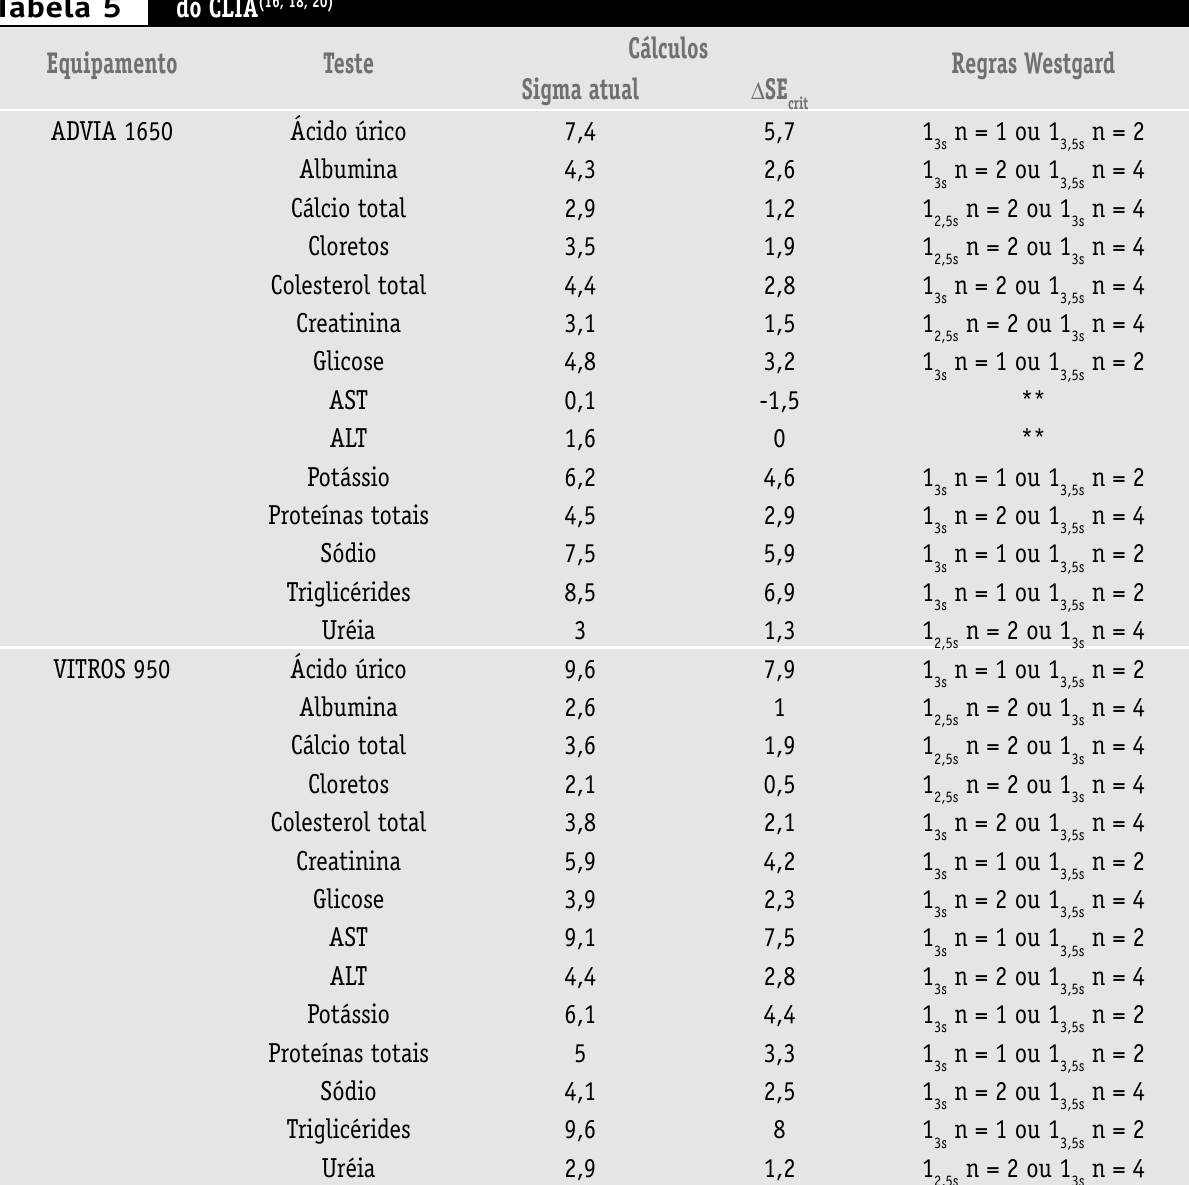
A Tabela 6 apresenta as freqüências em cada intervalo, conforme foram distribuídas no presente estudo (CLIA como referência de especificação). mos visualizar uma tendência a valores maiores nesse índice, para os analitos em estudo, no equipamento VITROS 950 ® . Isso, em última análise, pode representar a presença nesse equipamento de testes com menor tendência a resultados fora dos limites aceitáveis, passíveis de serem controlados através de regras de controle de qualidade menos